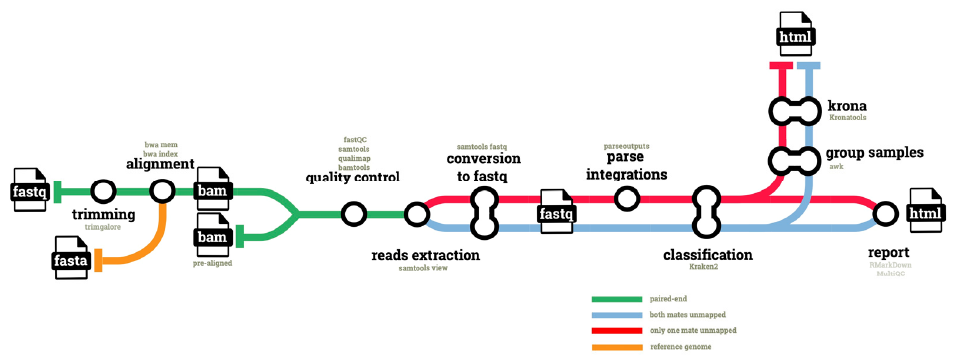
Figure 1. Diagram of the hgtseq pipeline. The figure shows the key steps and input/output files composing the pipeline. Different colours indicate the processing of different data types, such as unmapped reads extracted from the aligned BAM files, which are categorised using samtools flags, depending on whether both mates are unmapped, or just one of the two mates is unmapped.